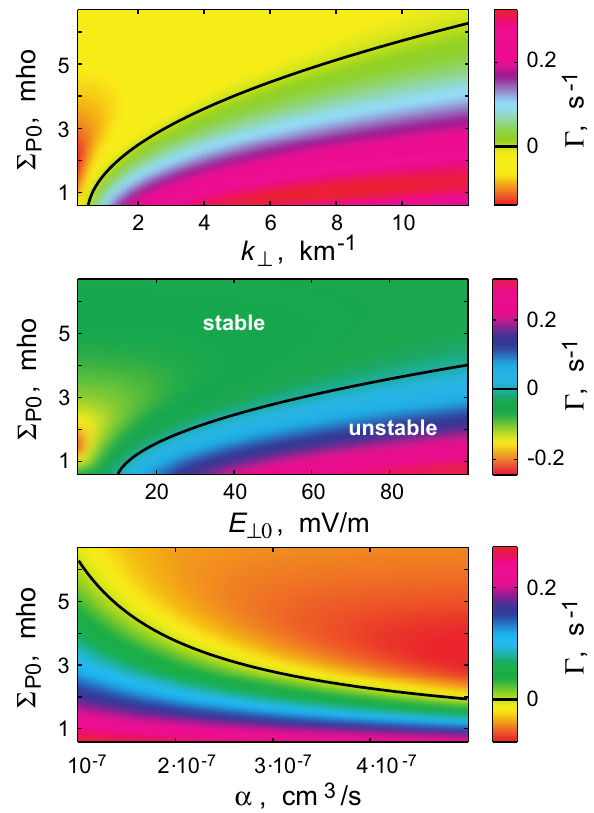
Fig. 1. (Top) Time variations of the ionospheric plasma recombina- tion coefficient, α , (solid line) and the electron collision frequency, ν e , (dashed line). (Bottom) Time variations of the field-aligned cur- rent density, j k measured at the ionosphere at L =6.2 when the heater is turned off all the time (thick line) and when the heater is turned on after t =40s (thin